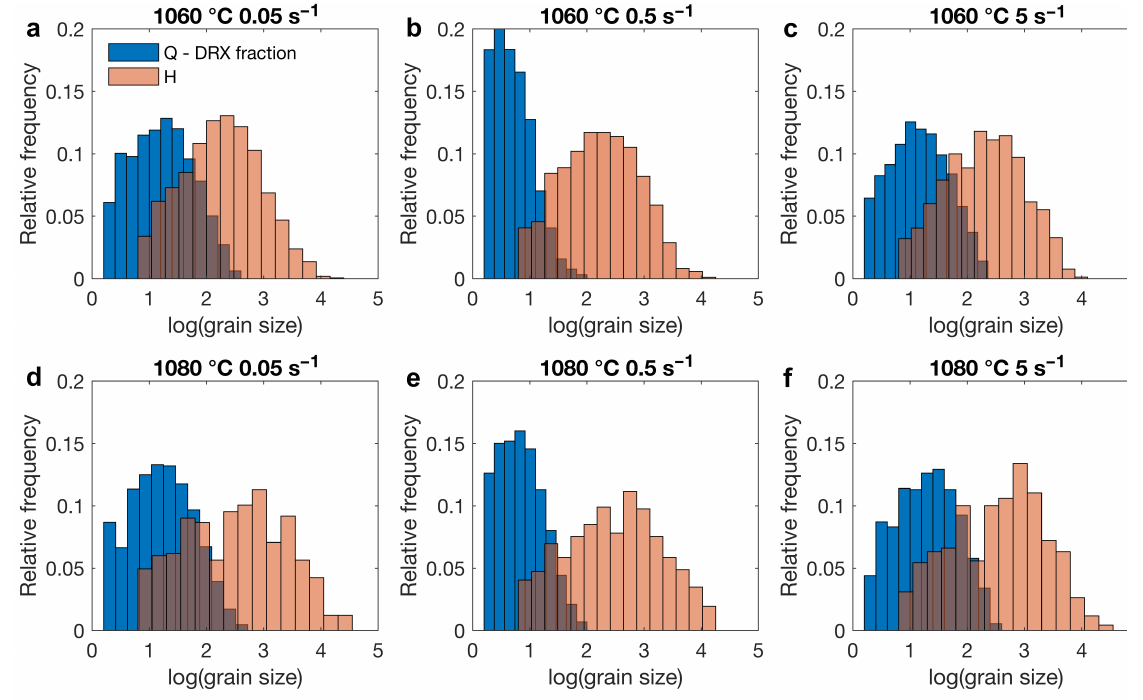
Figure 13. Histograms of the logarithm of the relative frequency of grain size in the DRX fraction in Q samples, and the full data set in H samples. ( a – c ) samples deformed at 1060 ◦ C and 0.05, 0.5 and 5 s − 1 respectively. ( d – f ) samples deformed at 1080 ◦ C and 0.05, 0.5 and 5 s − 1